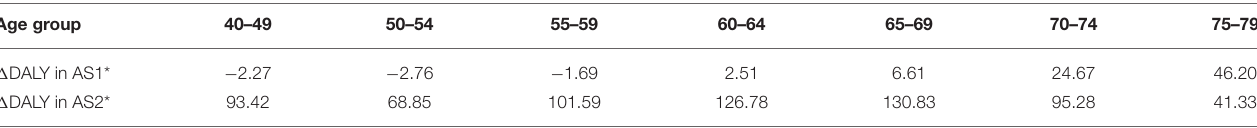
TABLE 7 | Risk–benefit assessment of two alternative rice consumption scenarios compared to the baseline consumption in different age groups of adult men in China (in Disability–Adjusted Life Year difference, 1 DALY).